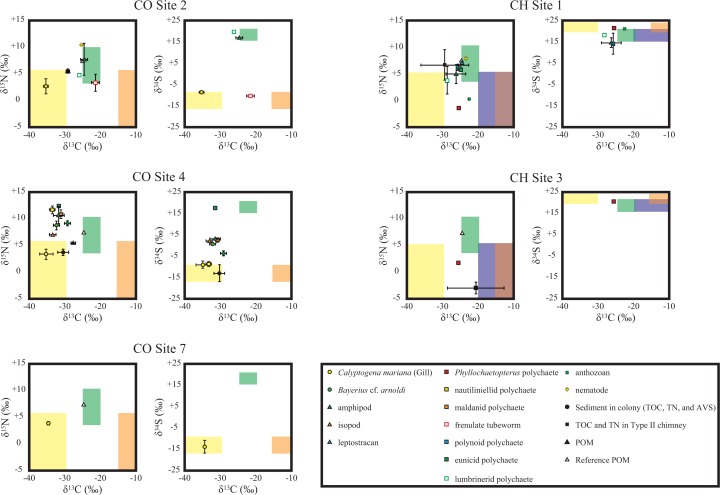
Plots of carbon versus nitrogen and carbon versus sulfur isotopic compositions of animal soft tissues obtained from CO (a, b, and c) and CH (d and e) Sites in the SSF.Yellow, orange, blue, and green shadows represent the expected ranges of the isotopic compositions of thiotroph-CBB, thiotroph-rTCA, methanotroph, and photosynthetically-derived organic matter, respectively. In CO Sites, the ranges of isotopic signatures of methanotroph were not shown due to the low δ13C value (c. −48‰).